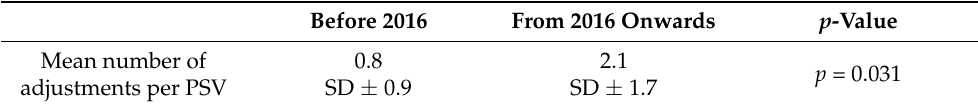
Before 2016 From 2016 Onwards p -Value 0.8 2.1 p = SD ± 0.9 SD ± 1.7